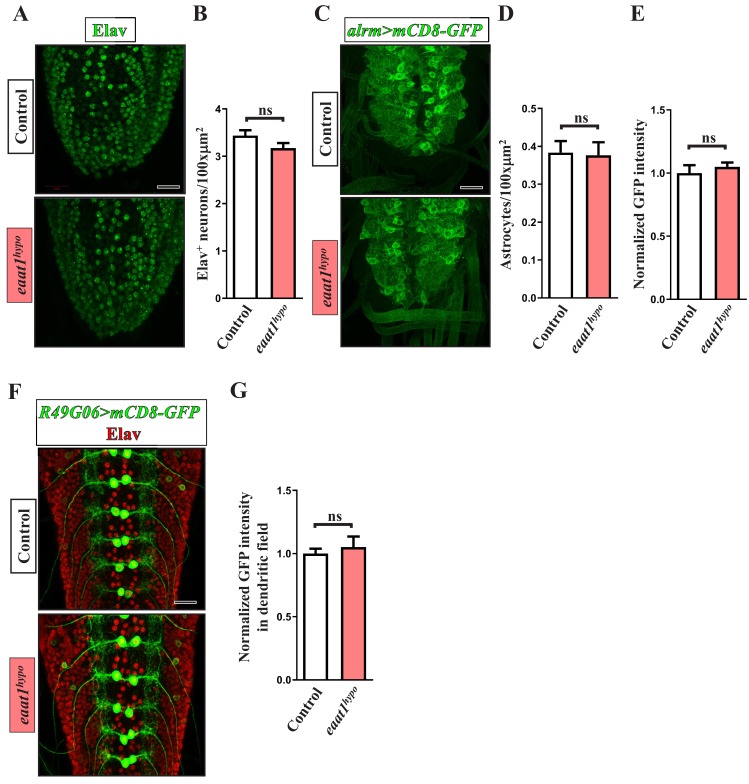
No overt change in the structural integrity of the larval VNC upon loss of eaat1.(A, C, F) Representative confocal images of VNCs stained with α-Elav (A, F) or α-GFP (C, F) obtained from third instar larvae of the indicated genotypes. Expression of UAS-mCD8-GFP driven by alrm-GAL4 and R49G06-GAL4 labels astrocyte-like glia and subsets of motor neurons, respectively. (B, D, E, G) Quantification data for the number of Elav-positive neurons per VNC area (B), the number of astrocytes per VNC area (D), averaged GFP staining intensity of astrocyte processes (normalized to the value of controls) (E), and averaged GFP staining intensity of the dendritic field of motor neurons (normalized to the value of controls) (G) (n ≥ 5 VNCs for each genotype). P value: ns, no significance. n: replicate number. Error bars indicate SEM. Scale bar: 20 μm. Statistics: Student's t-test.10.7554/eLife.47372.024Figure 5—figure supplement 1—source data 1.Source data for Figure 5—figure supplement 1.